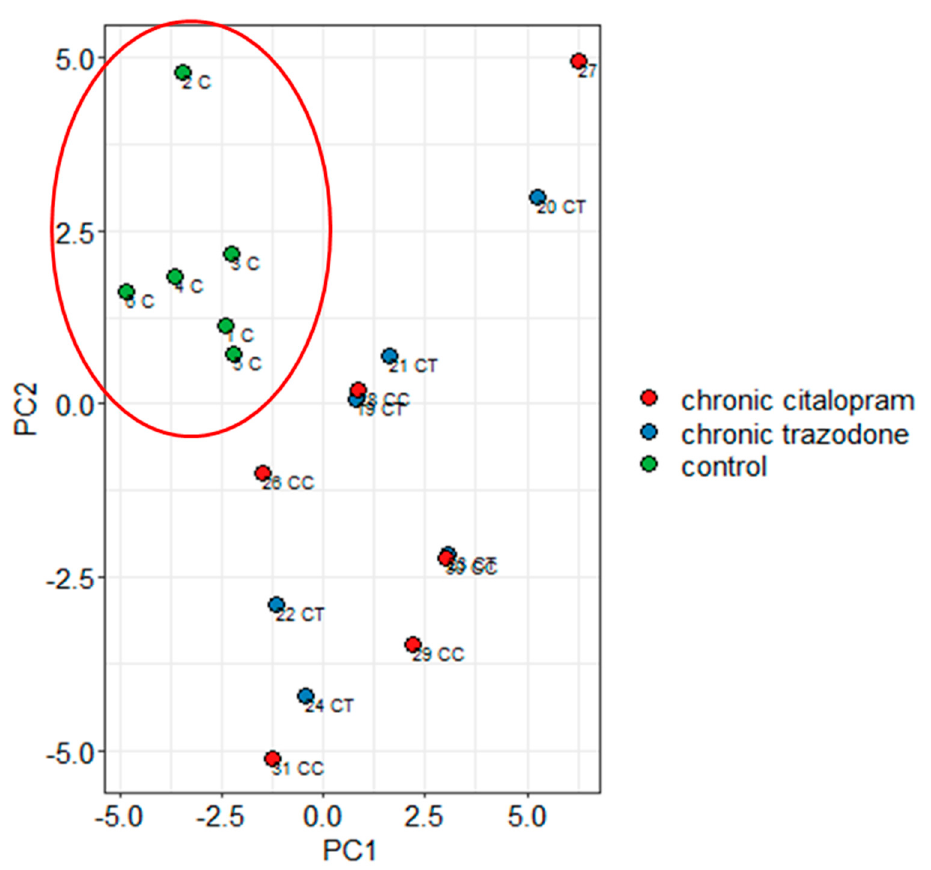
Figure 10. PCA of mRNA or protein levels of all genes/proteins investigated after chronic trazodone, chronic citalopram, or chronic vehicle (control) treatment. A clear separation by antidepressant versus vehicle treatment (circled) is observed by adopting an unsupervised approach.